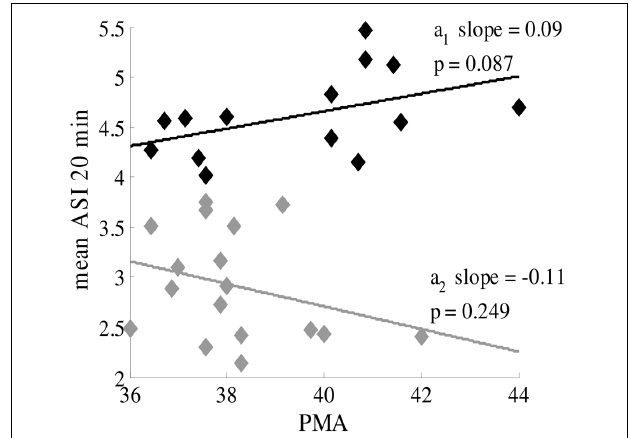
FIGURE 6 | ASI value is independent of postmenstrual age of the term infant (PMA > 36 weeks). Black labels represent healthy patients with synchronous patterns; gray labels are patients with asynchronous patterns. The mean ASI value is calculated for manually-selected 20-min periods (8 × 2 .